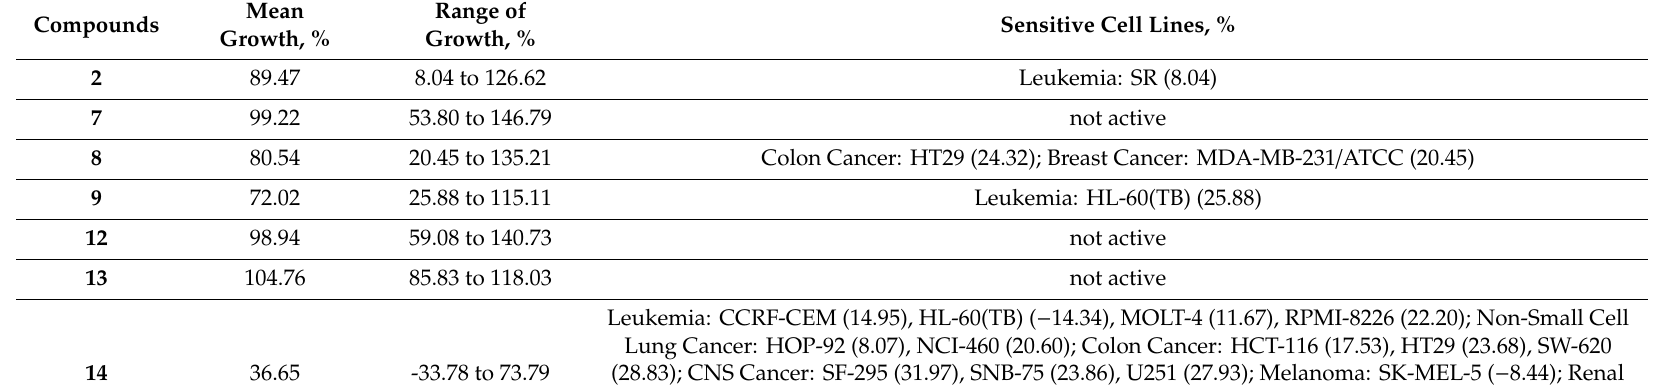
Table 1. In vitro anticancer activity in 60 human tumor cell lines for compounds 2 , 7–9 , 12–20 , 22 and 24–26 at 10 µ M.